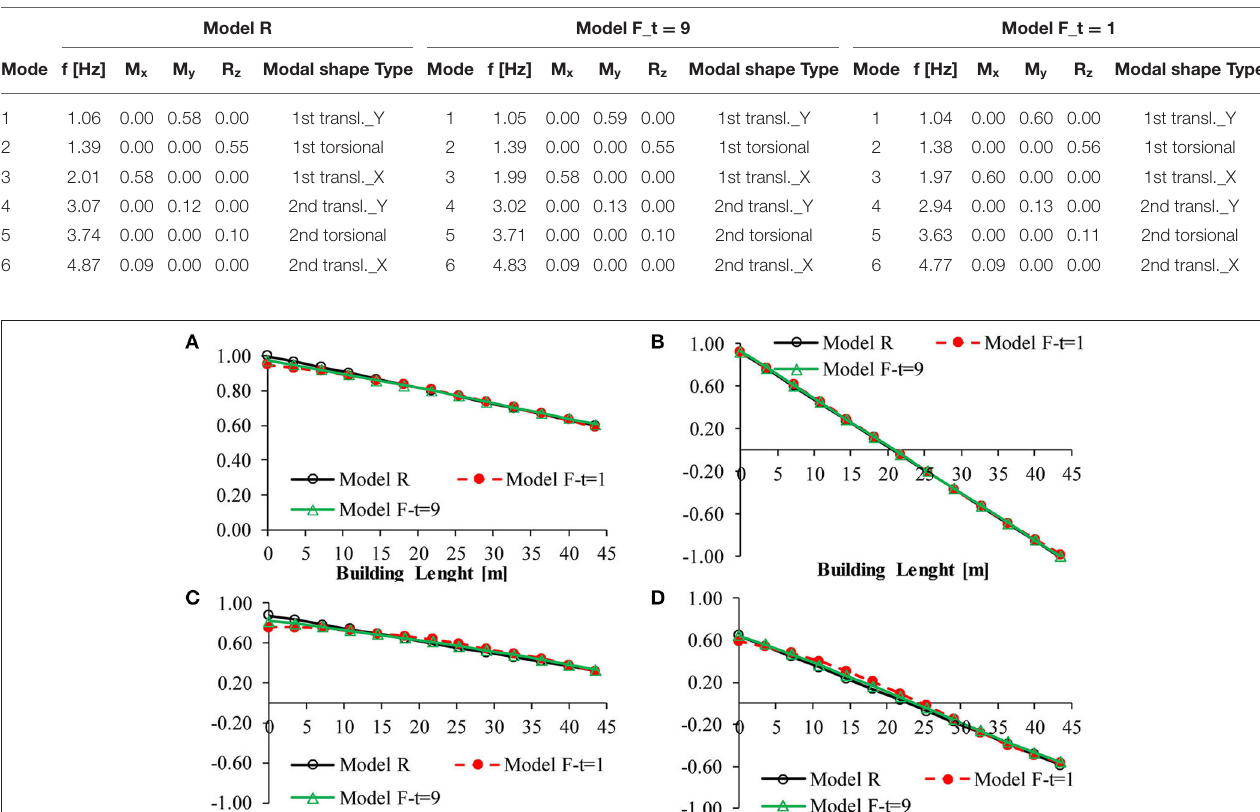
TABLE 3 | Modal properties of the models with different in-plane stiffness of the diaphragm.